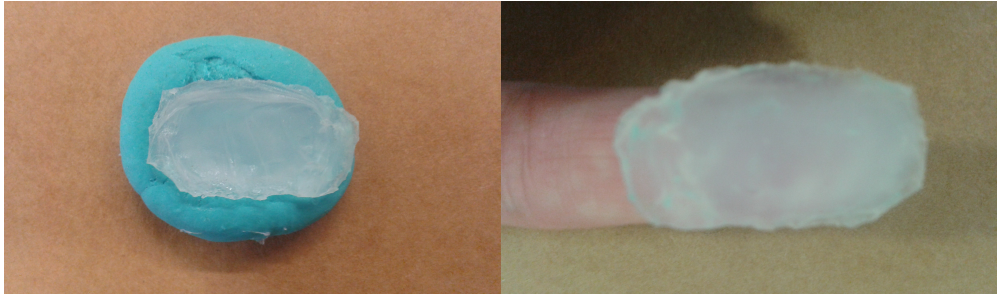
Figure 2. Finger Play-Doh mold and silicon